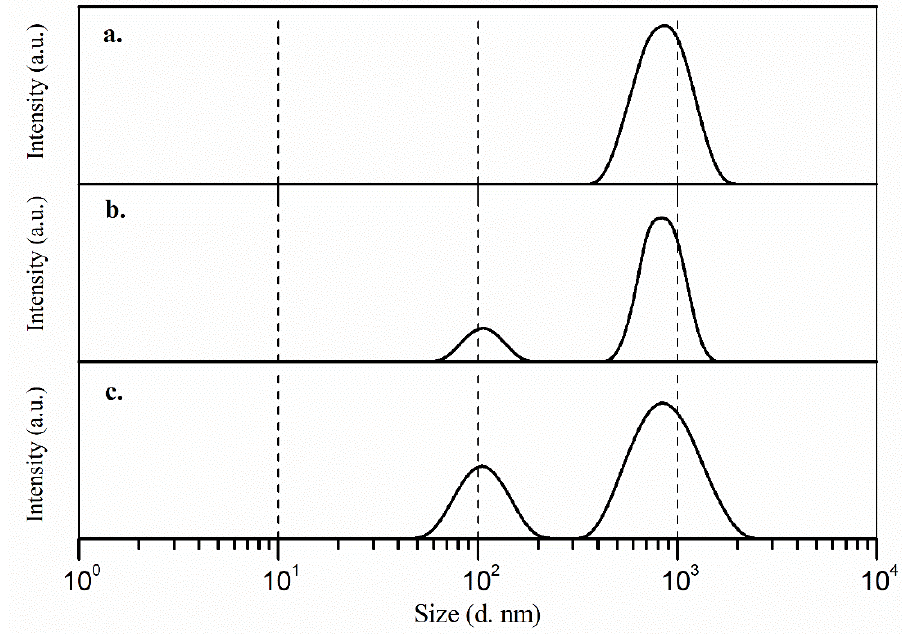
Figure 1. Size distribution (d. nm) of ( a ) κ C; ( b ) κ C:Dx; and ( c ) EDOT: κ C:Dx dispersions, measured by dynamic light scattering (DLS) method. dynamic light scattering (DLS)